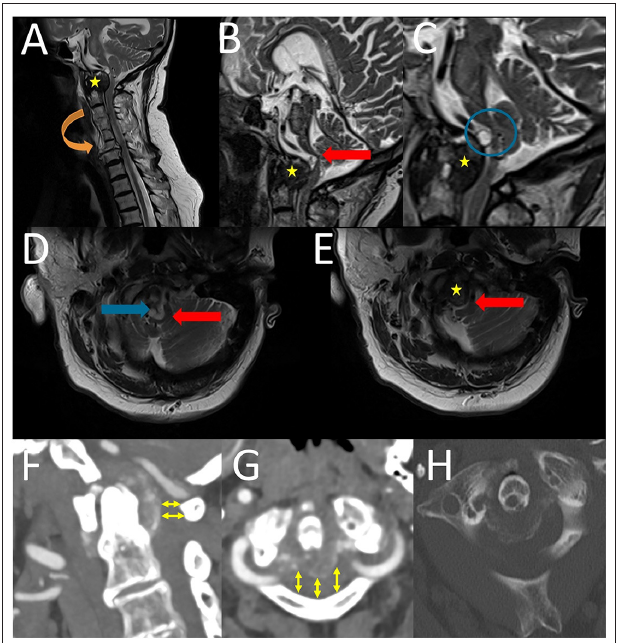
FIGURE 1 | Preoperative sagittal (A–C) and axial (D,E) T2-weigthed magnetic resonance images revealed a lesion of the OP and the retro-odontoid region (yellow stars) with brainstem compression and displacement (red block arrows) and also cystic component (blue block arrows and blue circle). Furthermore, the cervical vertebral bodies C3 to C6 were fused due to Saethre-Chotzen syndrome (orange block arrow). Preoperative CT and CTA of cervical spine (F–H) : A sagittal (F) and an axial (G) CTA (soft tissue window) revealed a “normal” anatomy of the vertebral artery and furthermore a spinal stenosis in the level of C 1 (yelow arrows). An axial CT (bone window) showed a “horseshoe” or “crown-like” calcification, which is located posterior to the OP (H) .